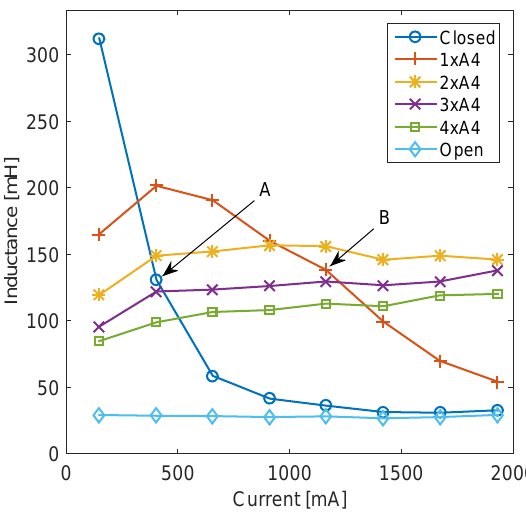
Figure 14. Average electromagnet current versus calculated dynamic inductance for the closed circuit, four different air-gaps and the fully open circuit. A and B mark the two cases where a good magnetic contact was